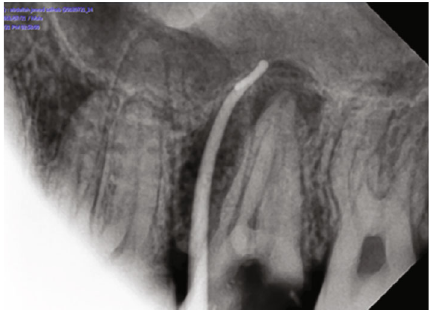
Figure 4: Periapical X-ray shows gutta-percha inserted through sinus.